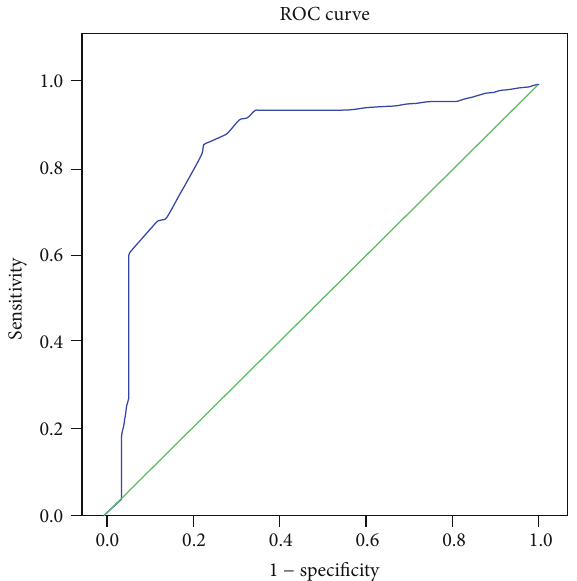
Figure 3: The ROC curve of pupillary response and